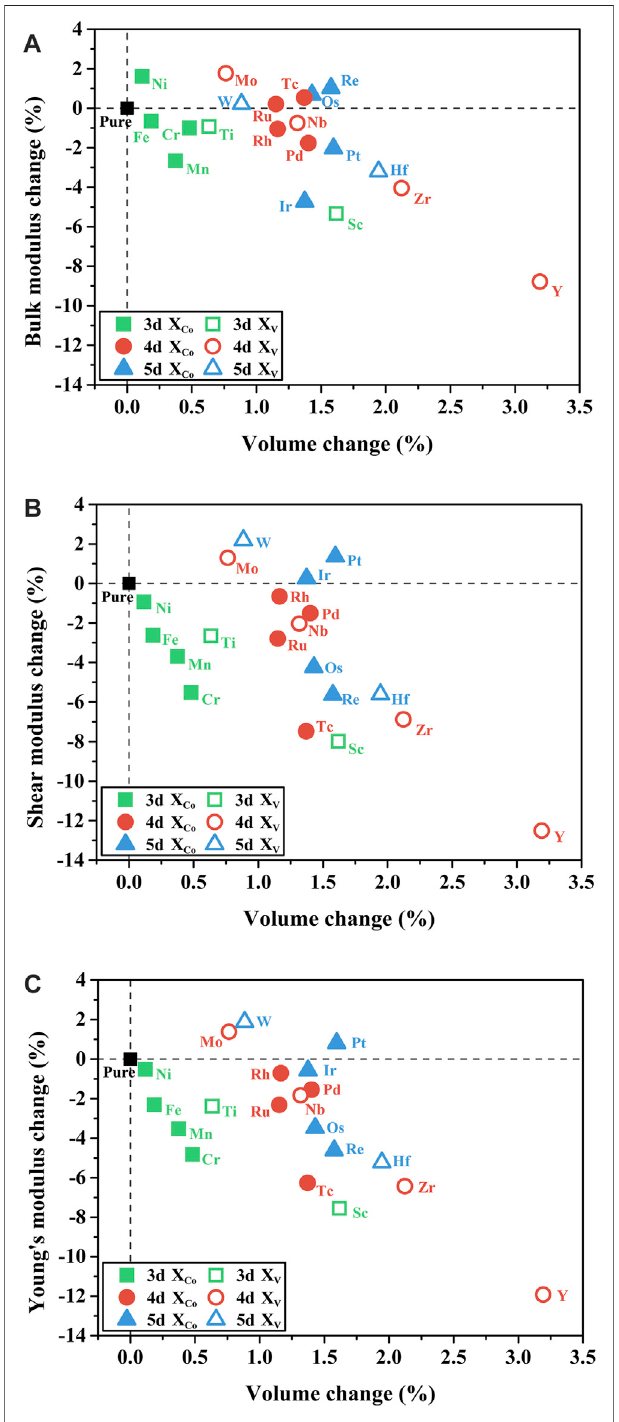
FIGURE 4 | Relationship between the elastic modulus changes and volumechanges ofX-substituted γ ′ -Co 3 (V, Ta): (A) bulk modulus B , (B) shear modulus G , and (C) Young ’ s modulus E .